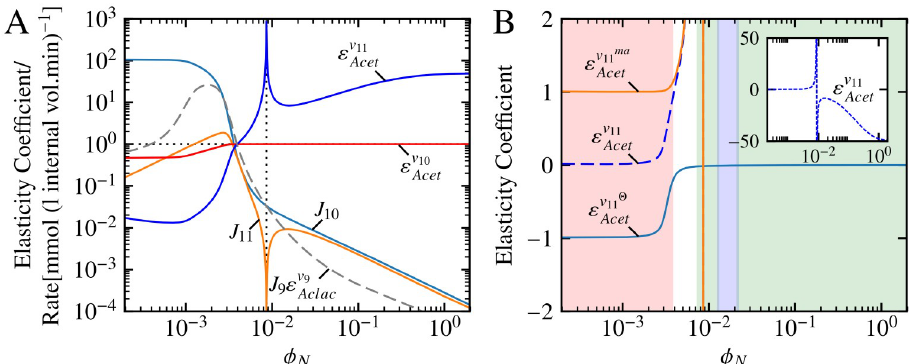
Fig 6. The flux and elasticity components of T4 and T6 as functions of ϕ N . (A) The elasticity and flux factors that , whereas J 10 and ε v 10 are unique to T4, constitute the multipliers T4 and T6. Both multipliers share the factor J ε v 9 9 Acet Aclac and J 11 and ε v 11 are unique to T6. Logarithmic coordinates together with a horizontal black dotted line and absolute Acet values are used in the same fashion as in Fig 4 with the black vertical dotted line indicating the crossover from positive . (B) The elasticity coefficient ε v 11 split into its binding and mass action components. to negative values of J 11 and ε v 11 Acet Acet The insert shows ε v 11 on an expanded scale. Shaded areas indicate kinetic vs. thermodynamic control of v 11 with red: Acet ρ � 0.1, white: 0.1 < ρ < 0.9, green: 0.9 � ρ � 1/0.9 and blue: 1/0.9 < ρ < 1/0.1.